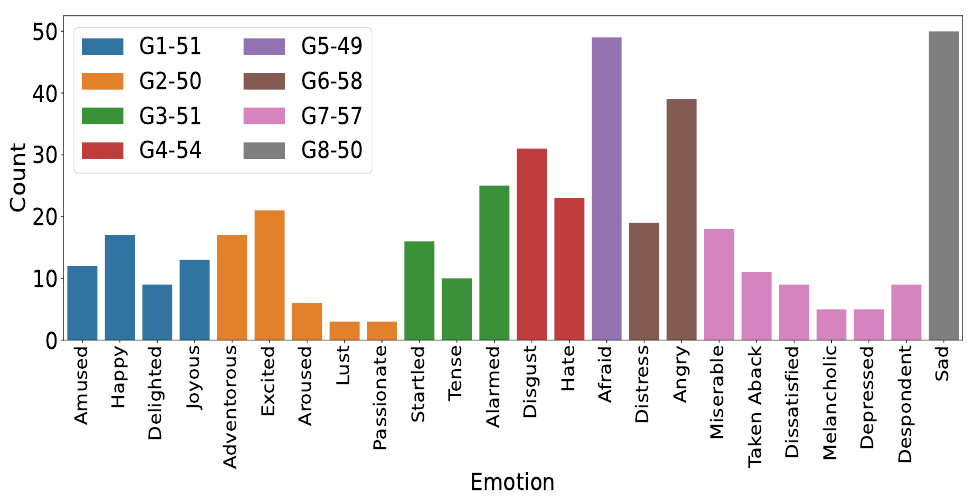
Figure 2. Representation and statistics of emotion groups: The histogram plot shows the number of time participants has rated any emotion category to express their emotional experience. Histogram bars in the same color form an emotion group. The legend shows the number of emotional instances per emotion group. The grouping criteria is described in Section 2.5.1. G1: happy, amused,